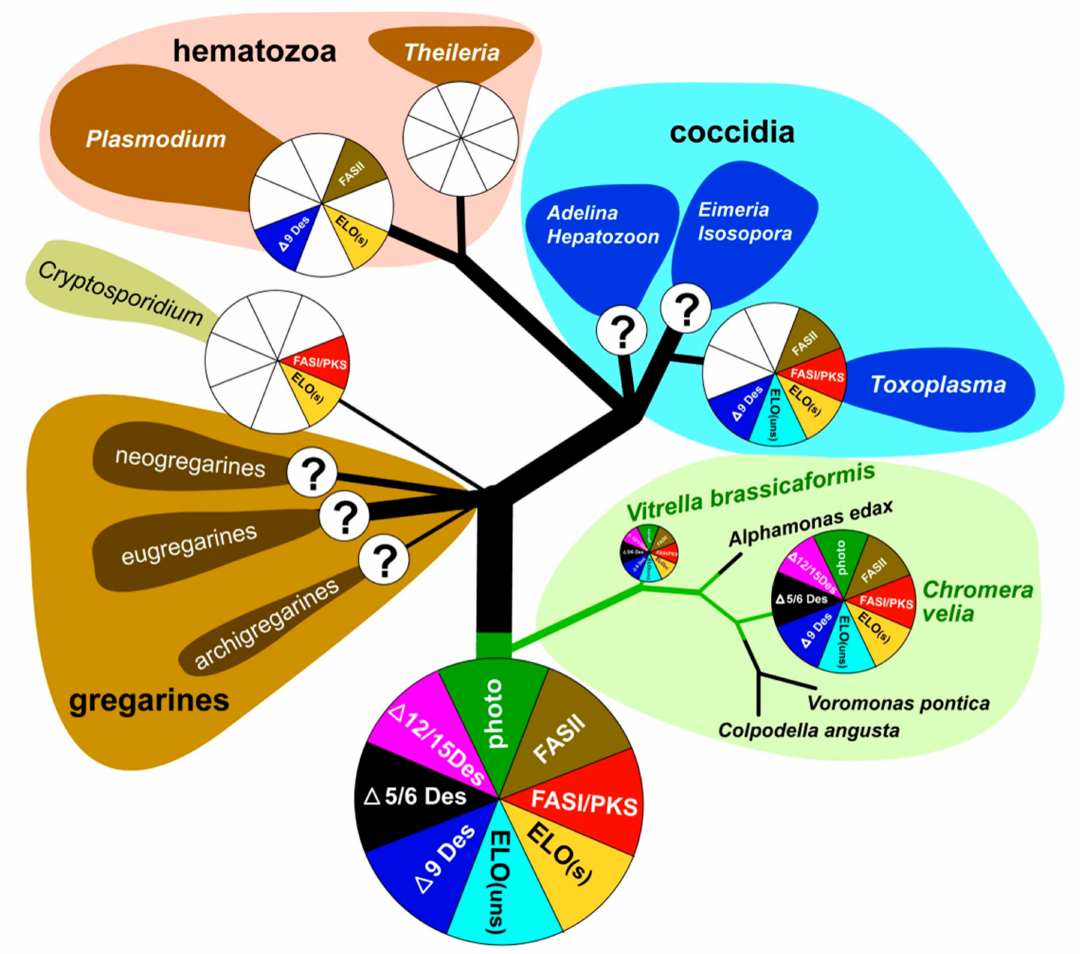
Figure 9. Overview of FAS evolution in chromerids and apicomplexan